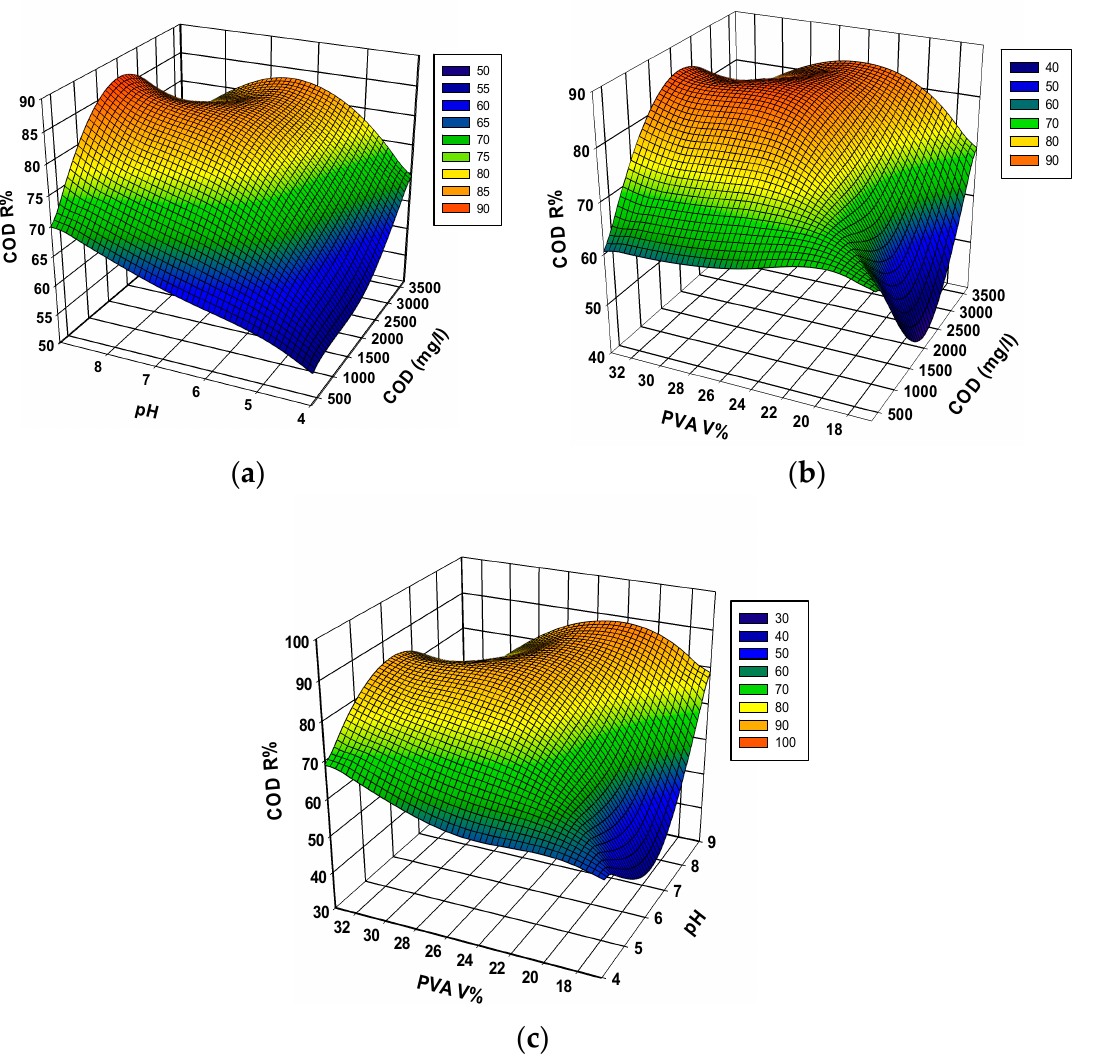
Figure 2. The interaction between the experimental parameters in the GTL experiment. ( a ) COD reduction% vs. pH and initial COD (mg/L); ( b ) COD reduction% vs. initial COD concentration (mg/L) and PVA volume fraction; ( c ) COD reduction% vs. pH and PVA volume fraction.